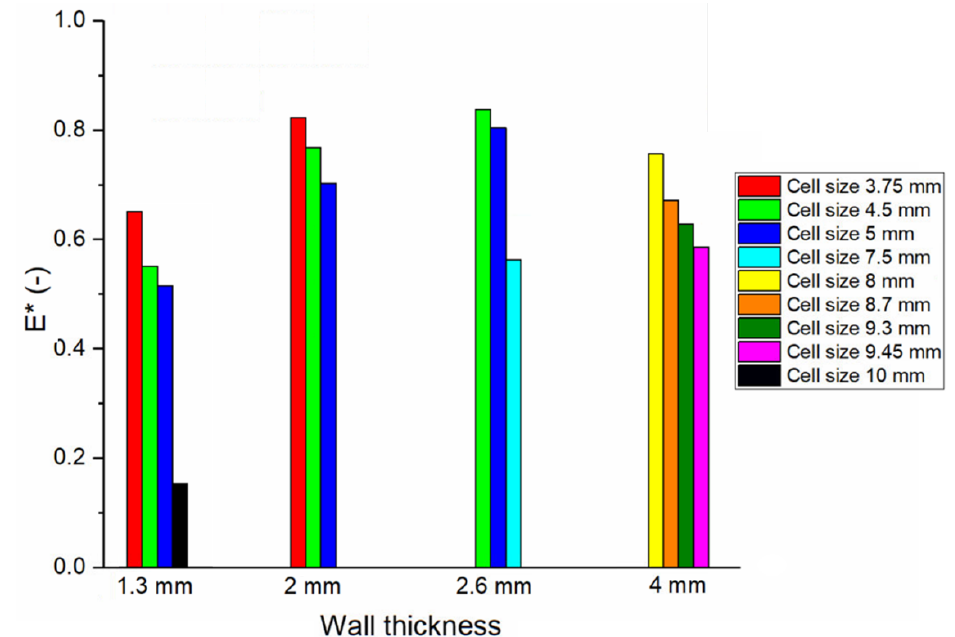
Figure 6. Relative Young’s modulus computed through FEM for designs with different wall thickness and cell size. Values increase with increasing wall thickness and decreasing cell size.